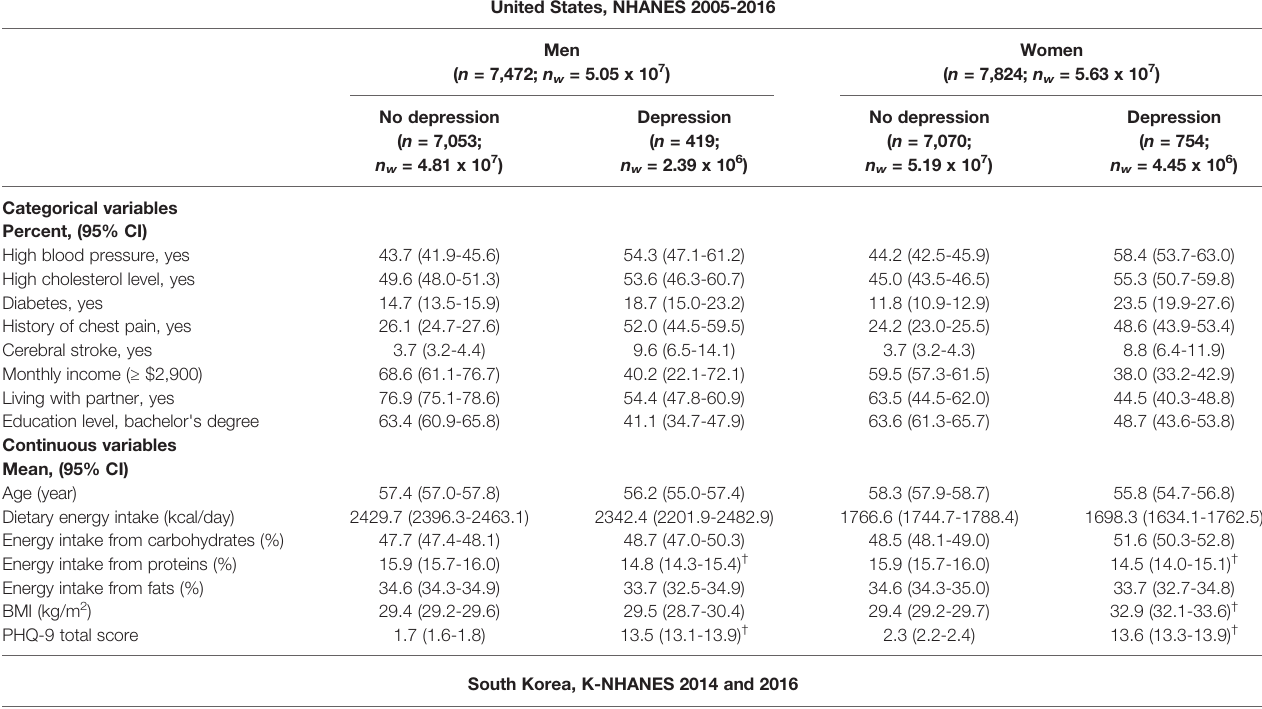
TABLE 1 | Selected characteristics of the weighted sample.